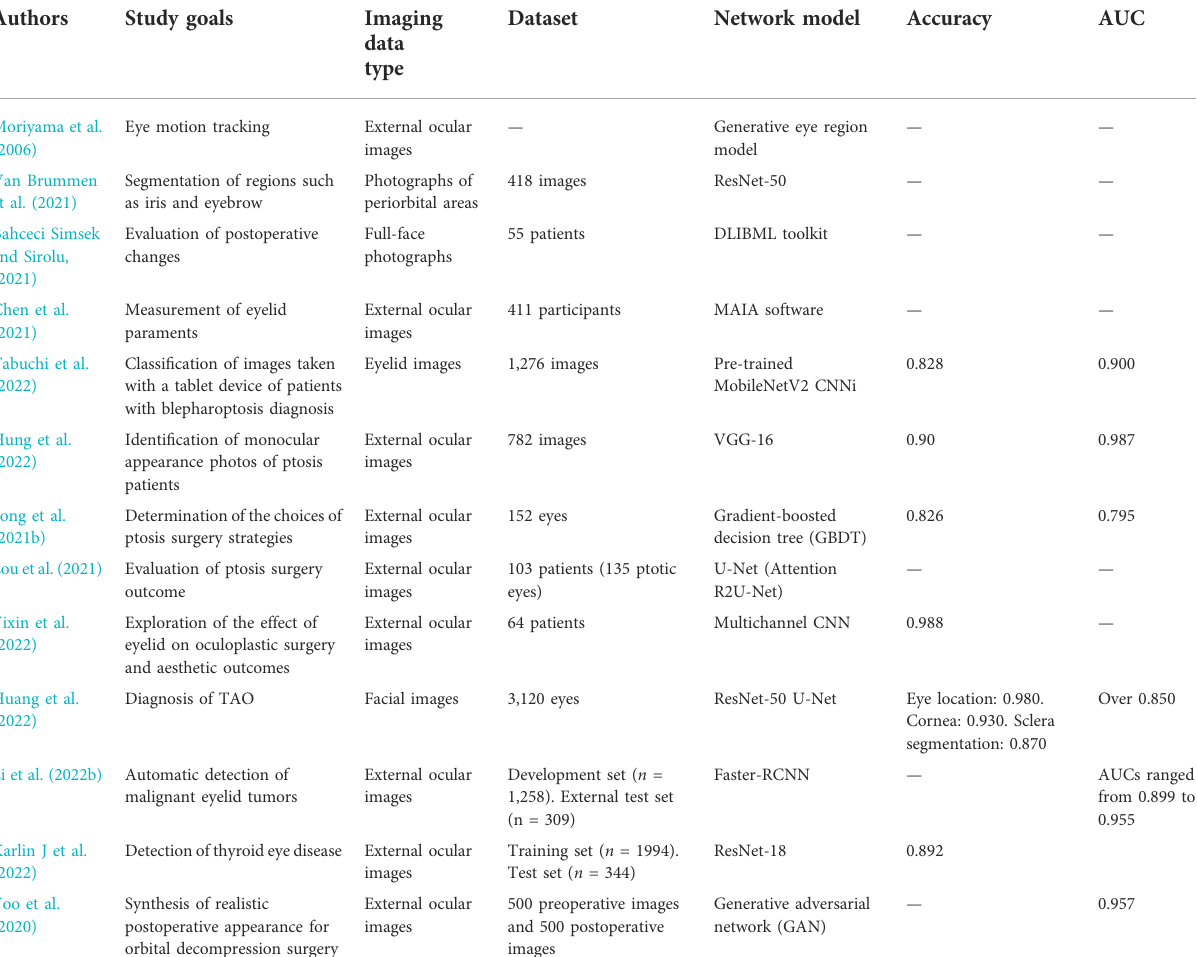
TABLE 2 AI-related studies utilizing external ocular